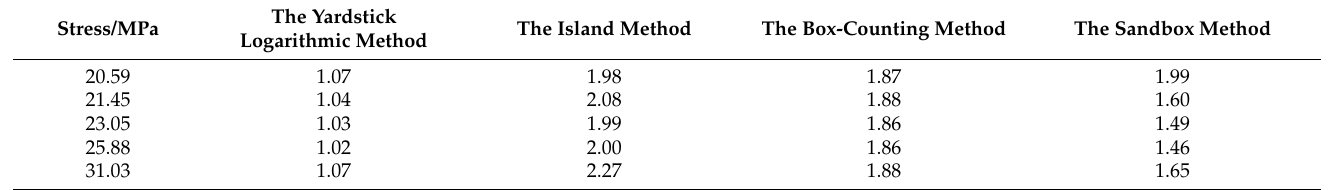
Table 3. Computing results of fractal dimension under each loading-step